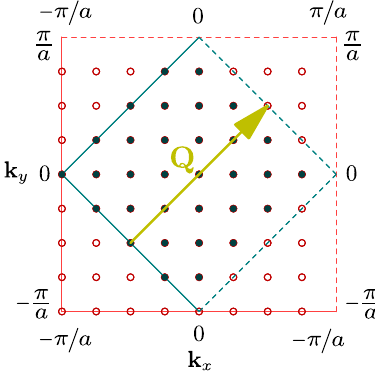
FIG. 1. Illustration of Brillouin zone indicated by the outer (red) square and RBZ by the inner (blue) square in an 8 × 8 lattice. The filled squares represent filled momentum states in the Fermi sea at